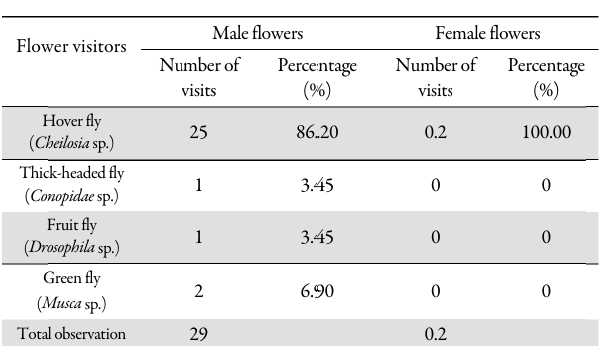
Table 1. Average number and percentage of visits of different species of Average number and percentage of visits of different species of Average number and percentage of visits of different species flies to male and female flowers of fluted pumpkin